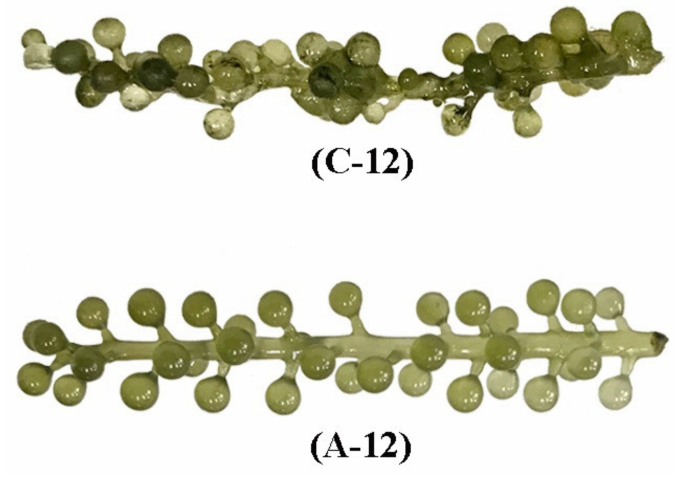
Figure 7. The appearance of seagrapes during post-harvest storage. The abbreviation of letters; C for control group and A for ACEF group. The abbreviation of numbers; 0 for day-0, 3 for day-3, 6 for day-6, 9 for day-9, and 12 for